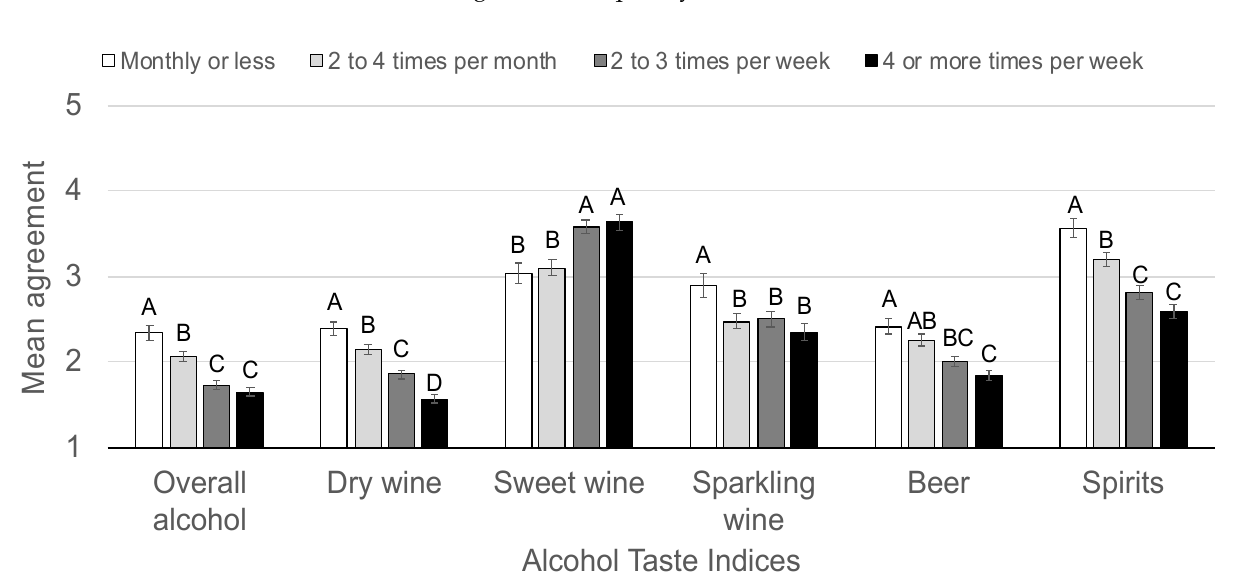
Figure 2. Mean scores for the alcohol taste indices grouped by frequency of alcohol consumption (monthly or less ( n = 132), 2 to 4 times per month ( n = 251), 2 to 3 times per week ( n = 269), 4 or more times per week ( n = 236)). Significantly different means from one-way ANOVA are indicated with different letters.